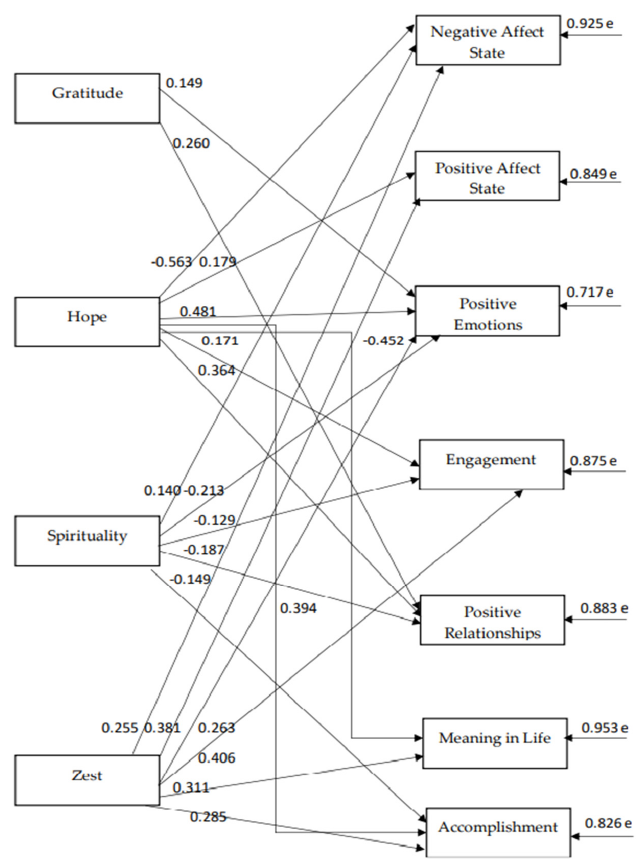
Figure 5. The relationships between transcendent virtue dimensions and subjective wellbeing components.